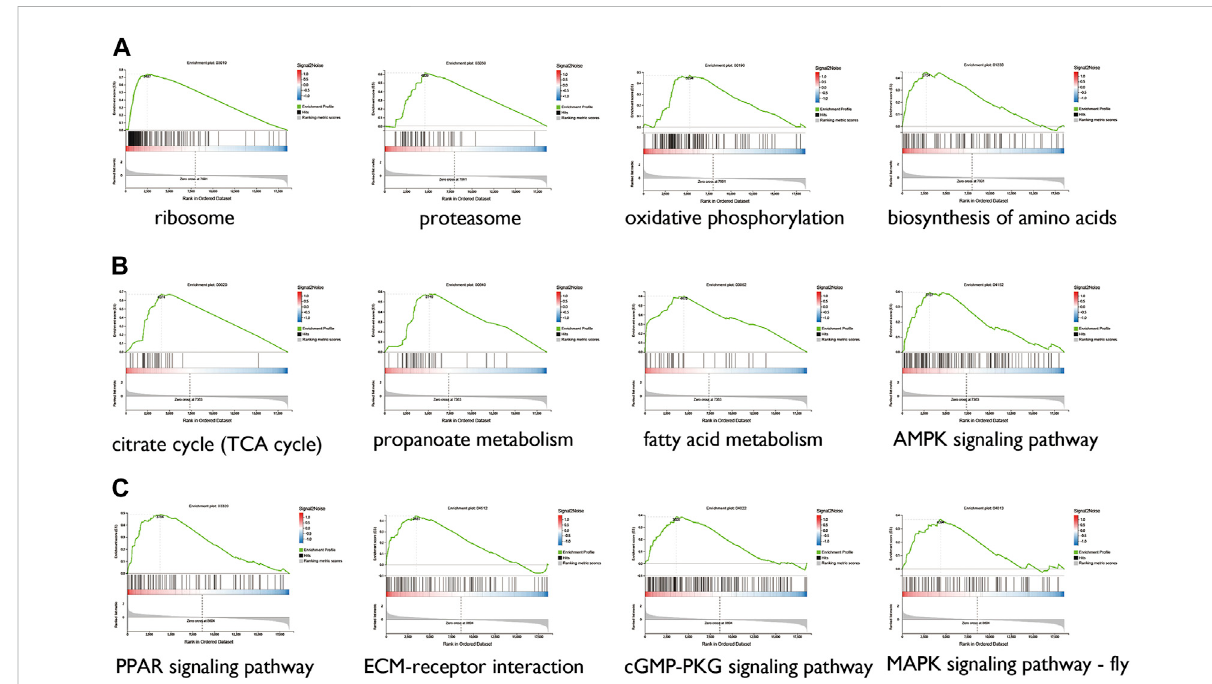
FIGURE 6 GSEA between the ARB-treated group and the SHR (A) , sacubitril/valsartan-treated group and the SHR (B) , and the ARB-treated and sacubitril/ valsartan-treated groups (C) TCA, tricarboxylic acid; AMPK, AMP-activated protein kinase; PPAR, peroxisome proliferator-activated receptor; ECM, extracellular matrix; MAPK, mitogen-activated protein